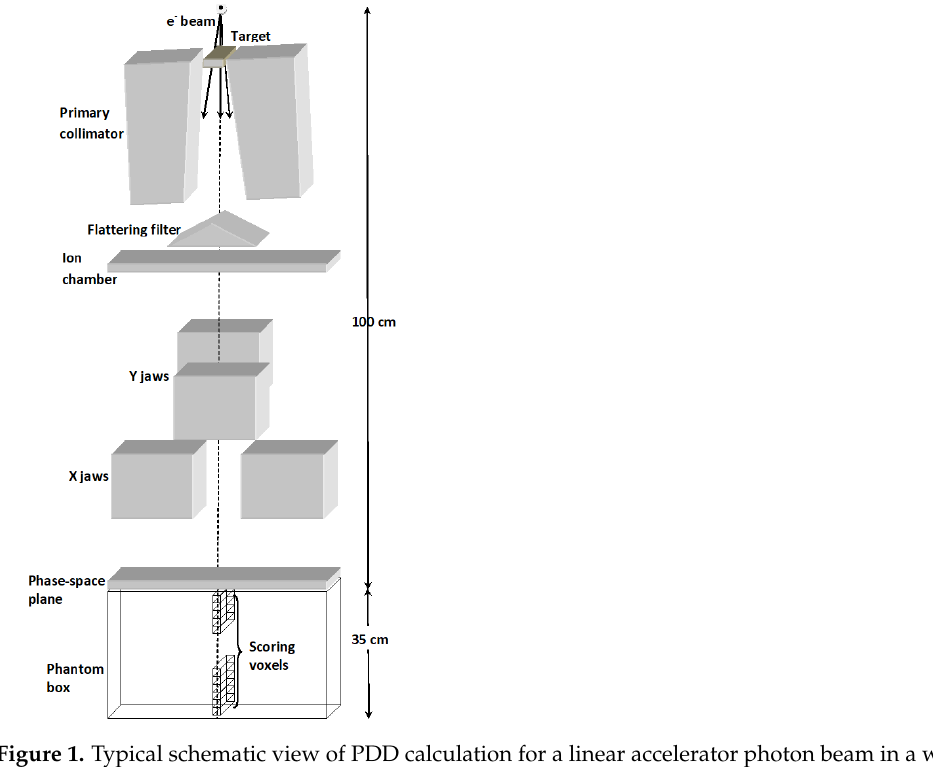
Figure 1. Typical schematic view of PDD calculation for a linear accelerator photon beam in a water phantom. The different parts of the head Linac and the voxels used to score the dose within the box are